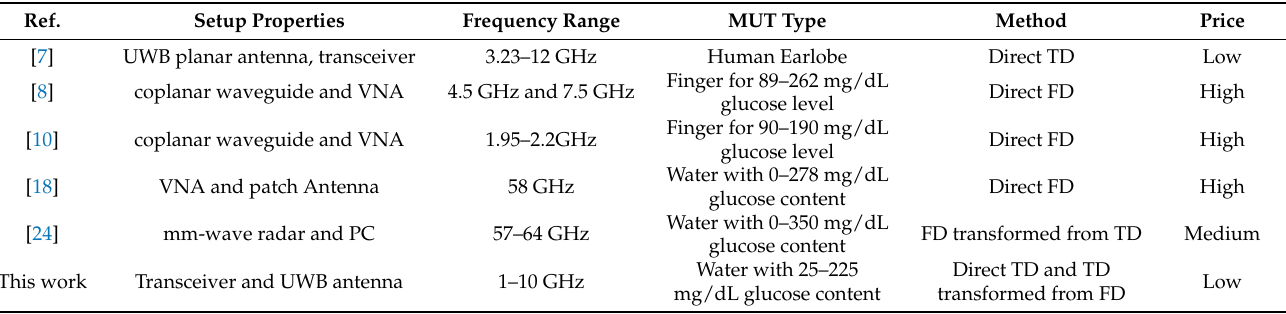
Table 2. Summary and comparison with related